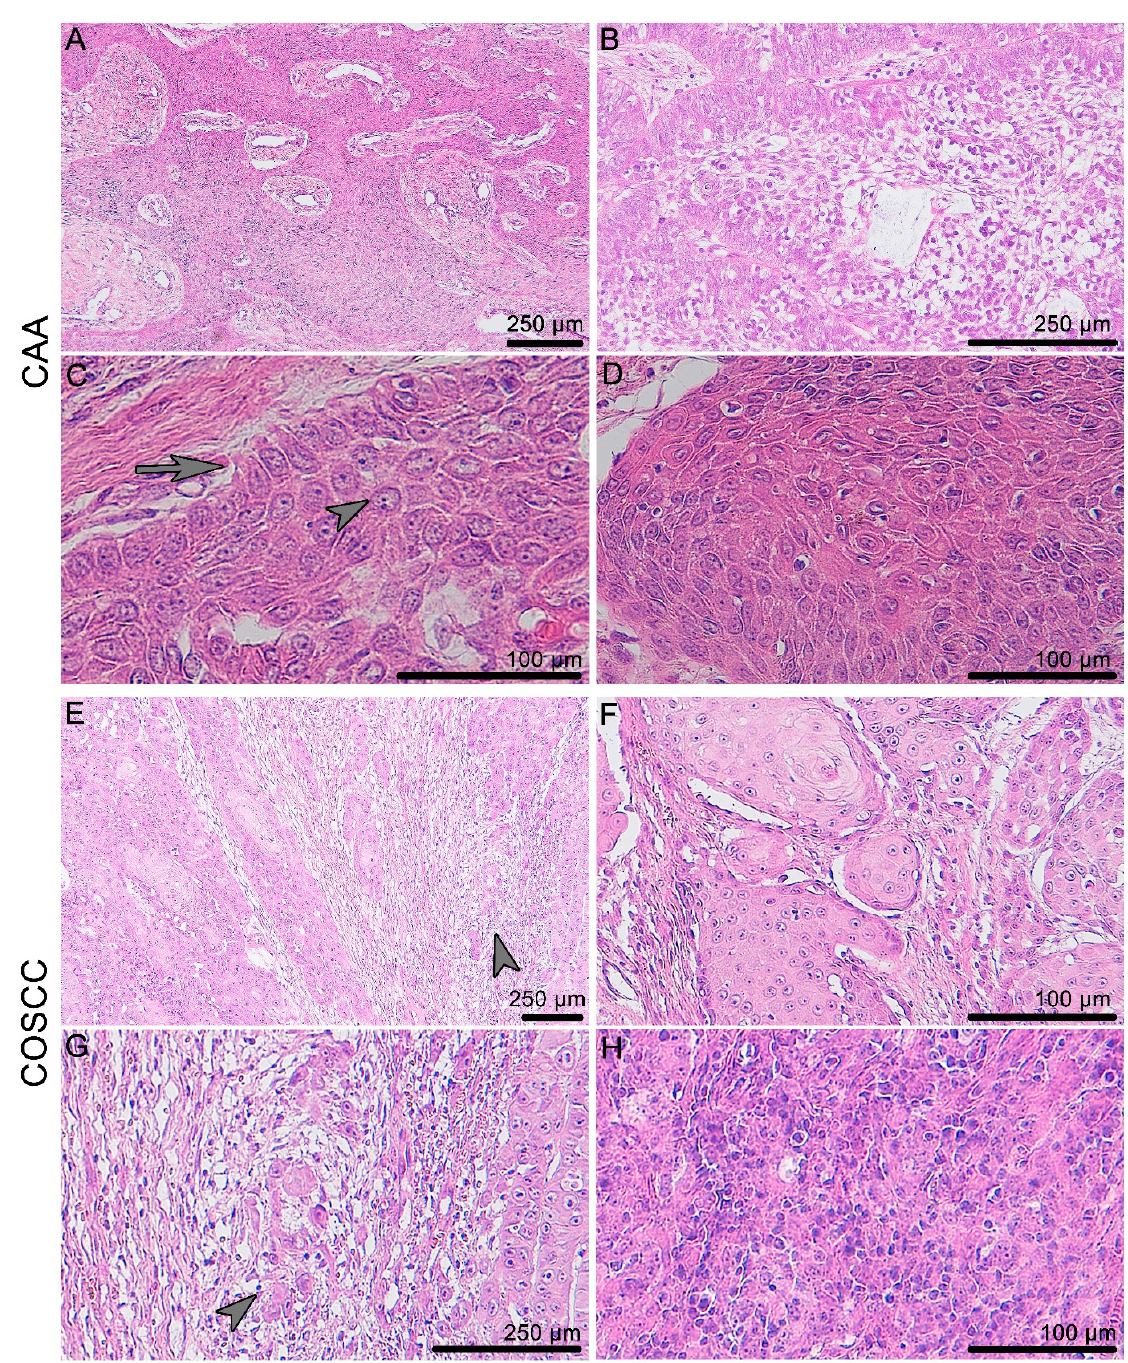
Figure 1. Microscopic anatomy of canine gingiva and histopathology of CAA and COSCC. ( A ) CAA grows invasively in the form of unencapsulated trabeculae of odontogenic epithelium surrounded by a primitive mesenchymal stroma. ( B ) The odontogenic epithelium can resemble stellate reticulum-like structures in the middle of the tumorous islets. ( C ) There is a characteristic palisading of the outer layer of epithelial cells, with often vacuolated cytoplasm, and the reverse polarity of nuclei (arrow) and prominent intracellular bridges can be found commonly in the centers of the islands (arrowhead). ( D ) Keratinization can occur as one of the features of this neoplasia. ( E , G ) Well-differentiated COSCC are characterized by an invasiveness and infiltrative “budding” on the periphery (arrowhead). ( F ) The level of keratinization is linked to the level of differentiation. ( H ) Poorly differentiated (non-keratinizing) tumors display marked cellular atypia and pleomorphism.